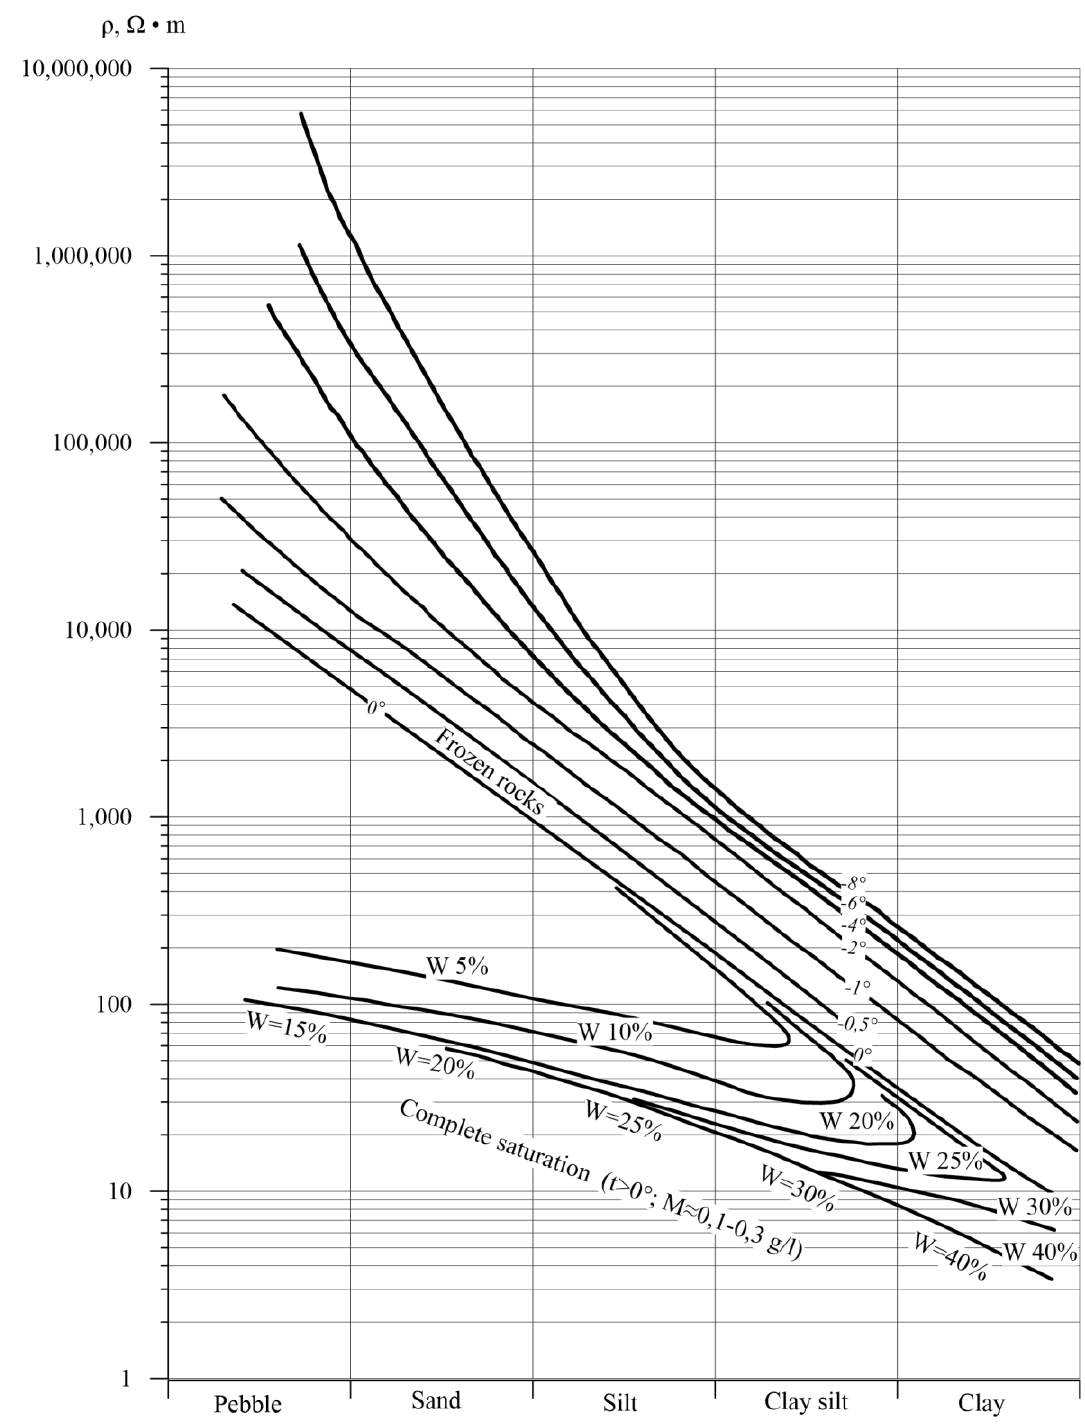
Figure 5. Approximate temperature dependences of resistivity for sediments of different lithologies: frozen soft sediments with massive cryostructure and water-saturated unfrozen sediments, with saturation > 5% [29].